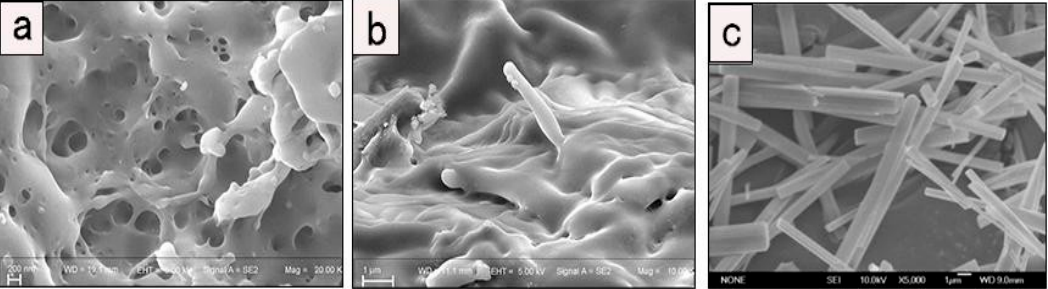
Figure 4. SEM images of PLLA ( a ), PLLA1 ( b ) and MgO whiskers ( c ). Polymers 2019 , 11 , x FOR PEER REVIEW